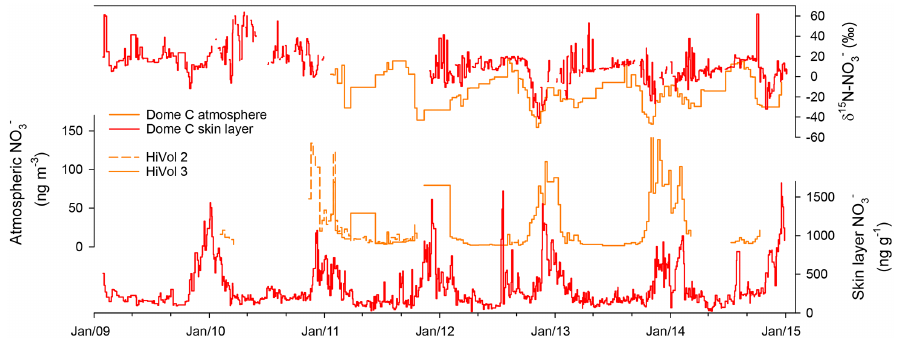
Figure 1. Year-round atmospheric and skin layer NO − were used at Dome C (HiVol 2 and HiVol 3) over the campaign and showed good reproducibility. Data sources: Erbland et al. (2013)